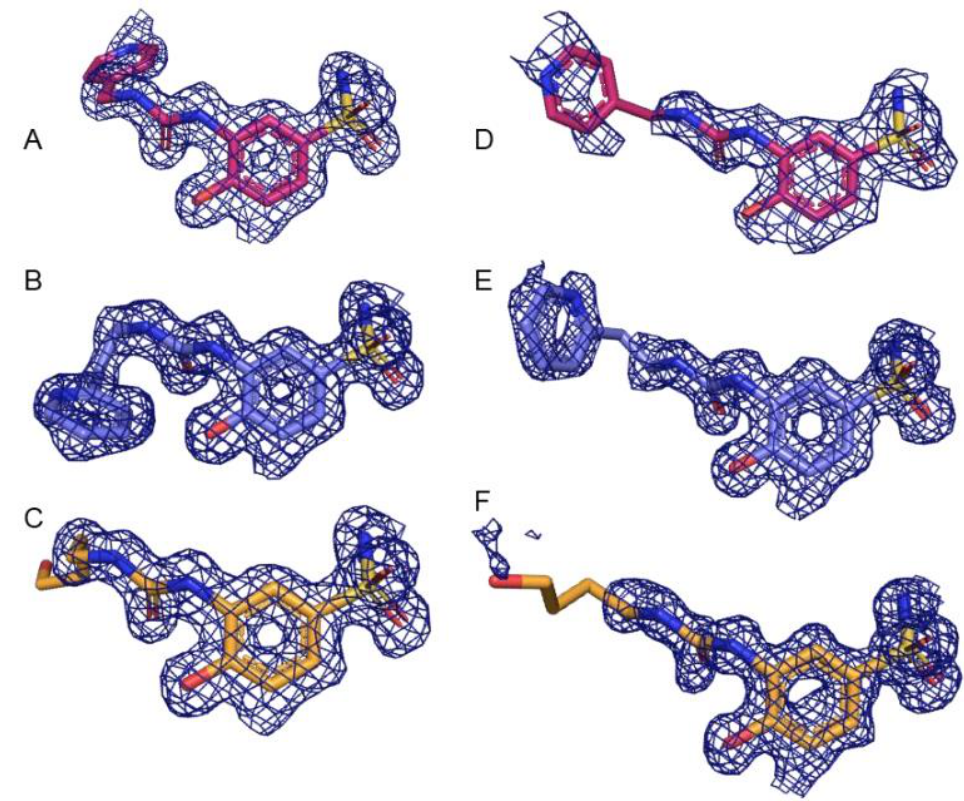
Figure 1. Electron density (blue mesh) of each complex at 1.0 σ. Compound 3g is shown in pink, compound 3h is shown in purple, and compound 3j is shown in orange. ( A ) Compound 3g bound to CA II, ( B ) 3h bound to CA II, ( C ) 3j bound to CA II, ( D ) 3g bound to CA IX-mimic, ( E ) 3h bound to CA IX-mimic, and ( F ) 3j bound to CA IX-mimic.